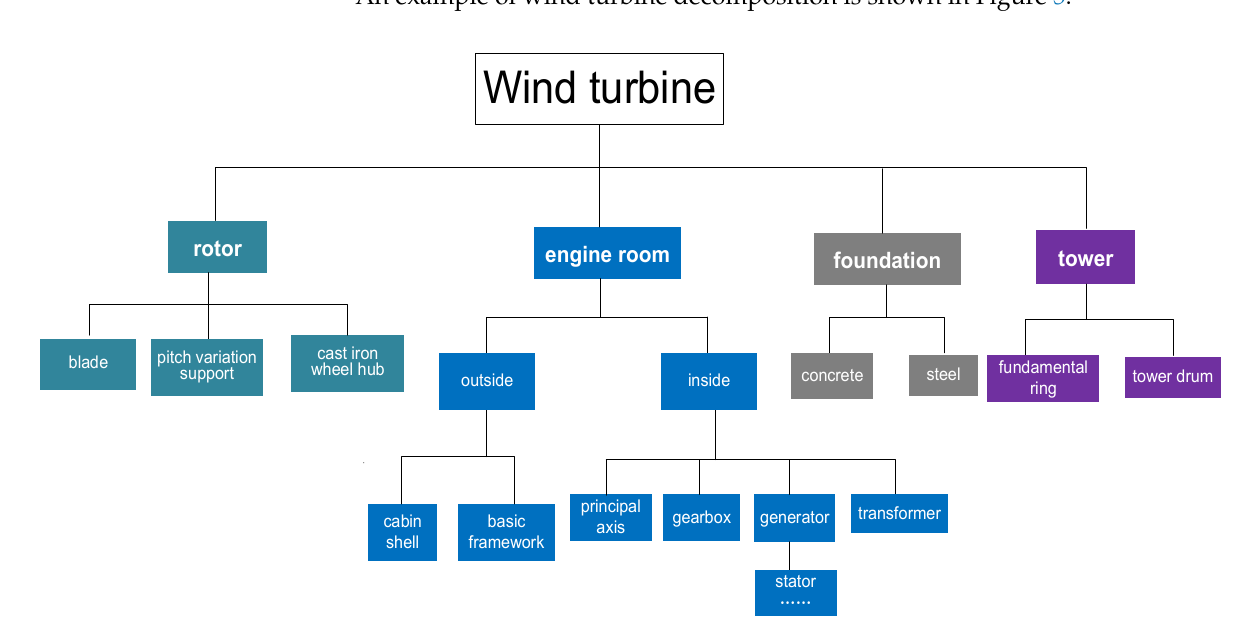
Figure 5. Decomposition of a wind turbine.